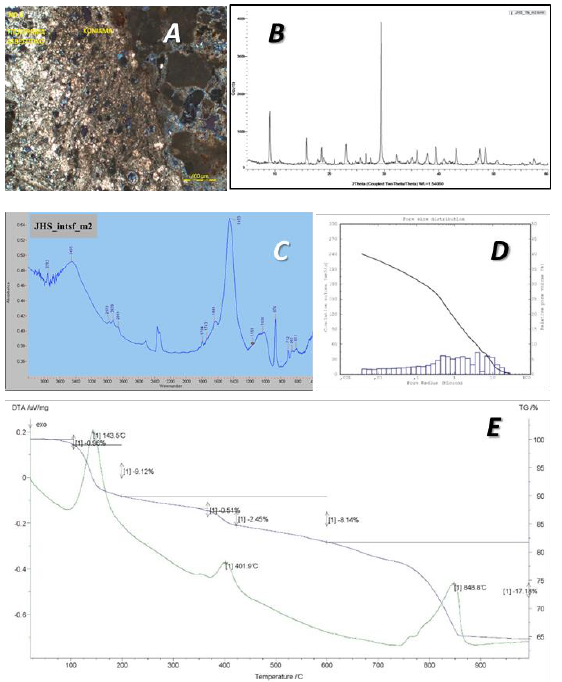
Figure 11: Typical results from the characterization study of historic mortars: A) Polarized Microscopy; B) X-Ray Diffraction (M3 mortar); C) Fourier Transform Infrared Spectroscopy (M2 mortar); D) Pore-size distribution curve (M1 mortar); E) Thermal Analysis DTA/TG (M3